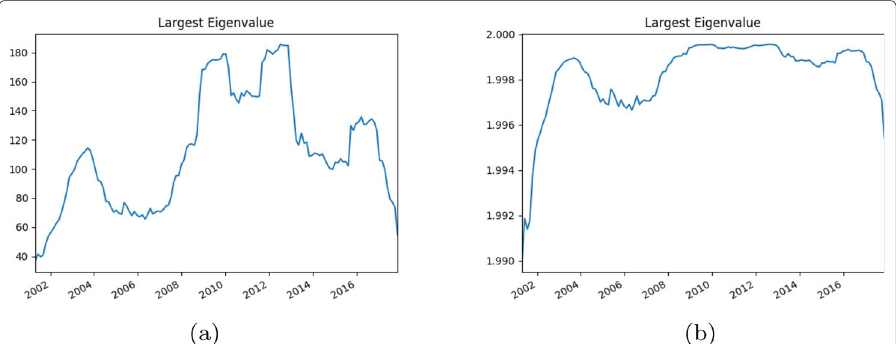
Fig. 5 Largest eigenvalue in the correlation (left) and partial correlation (right) networks. There is a large variation in the largest eigenvalue of the correlation matrix, with it varying from 180 to 40. It noticeably picks up the financial crisis of 2008/2009, where the eigenvalue reaches its maximum. The reverse is true in the partial correlation networks where the largest eigenvalue stays roughly constant (and quite small) showing the network has a consistent intensity, indicating the market state has been removed. a Correlation b Partial